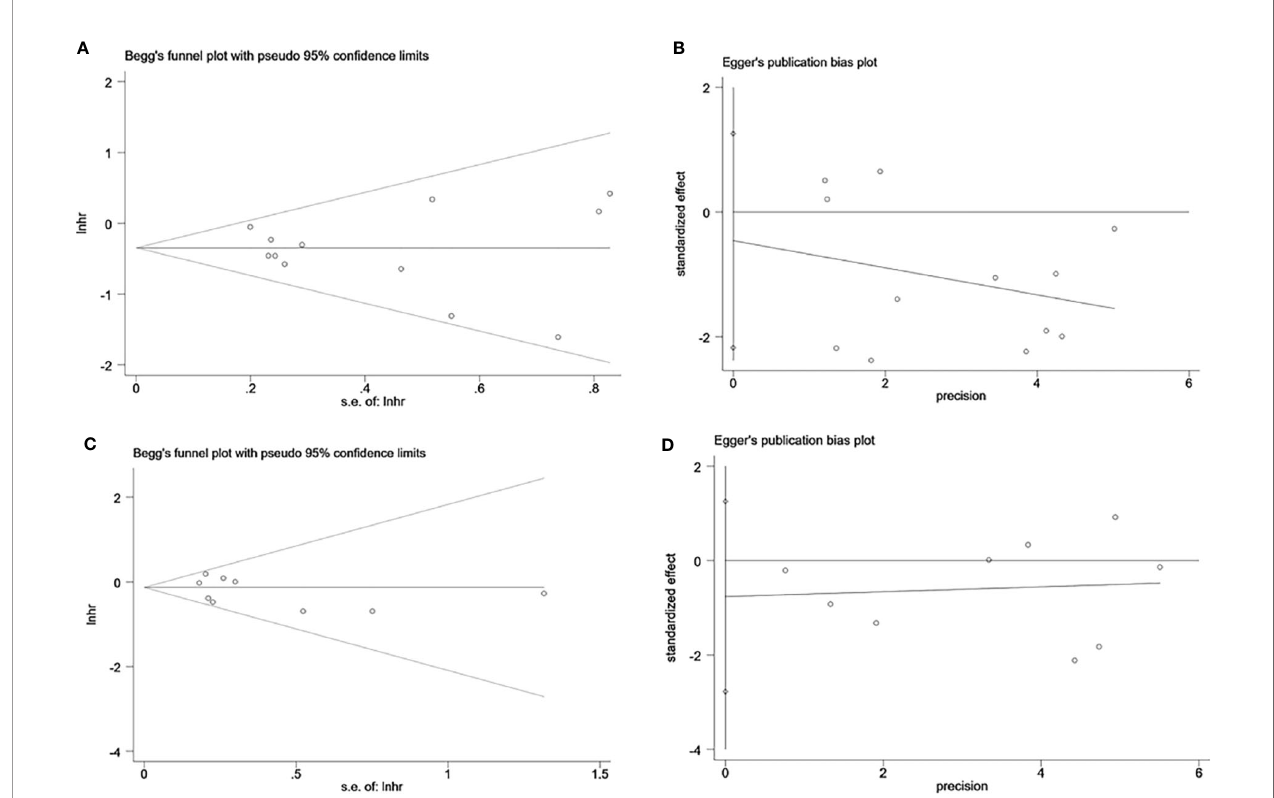
FIGURE 7 | Evaluation of publication bias of NK cells using Begg ’ s test and Egger ’ s test. (A) Begg ’ s test for OS of NK cells, P=0.732. (B) Egger ’ s test for OS of NK cells, P=0.564. (C) Begg ’ s test for DFS/RFS/TTR/PFS of NK cells, P=0.602. (D) Egger ’ s test for DFS/RFS/TTR/PFS of NK cells, P=0.401. lnhr, the ln of HR; s.e., standard error; NK, Natural killer; OS, Overall survival, DFS, Disease-free survival; RFS, Recurrence-free survival; TTR, Time-to recurrence; PFS, Progression-free